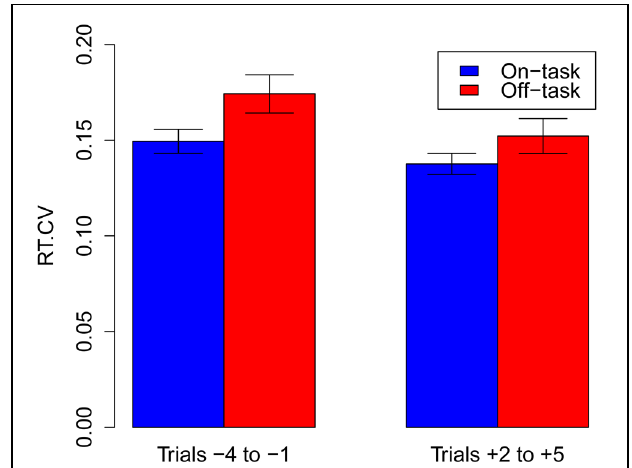
FIGURE 1 | RTCV (Response time coefficient of variability) as a function of whether participants are on-task or mind wandering (“off-task”), for both the trials preceding and following a report. Error bars are standard errors of the